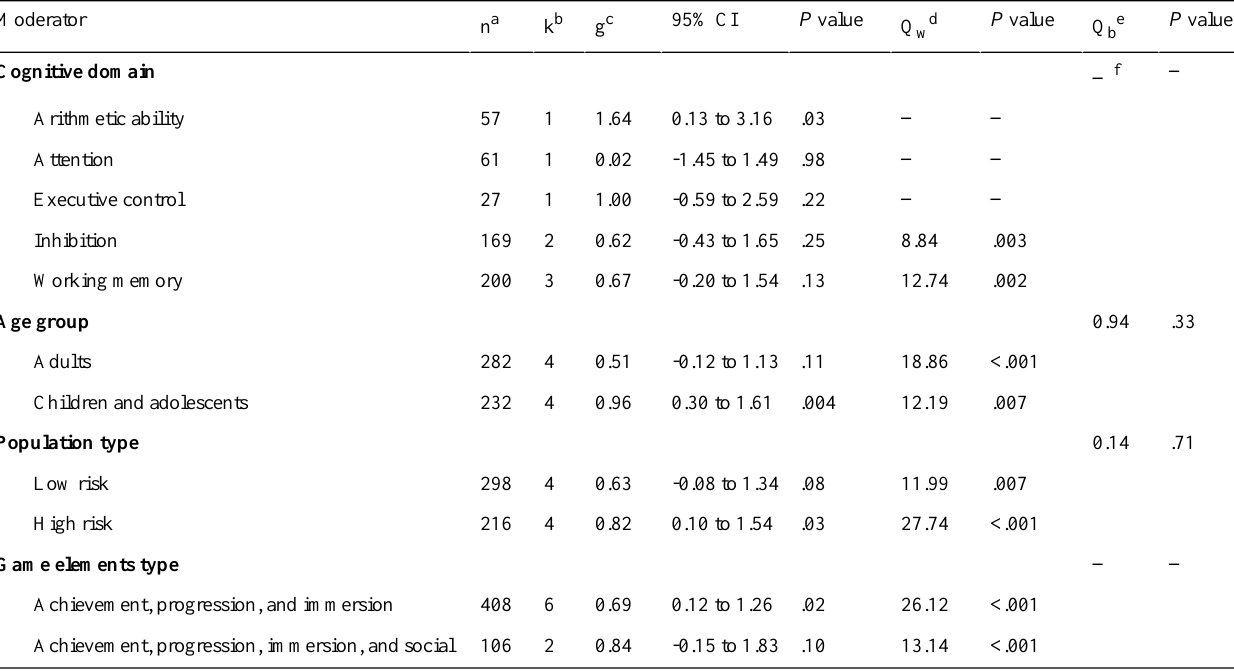
Table 2. Results of the subgroup analyses for motivation/engagement